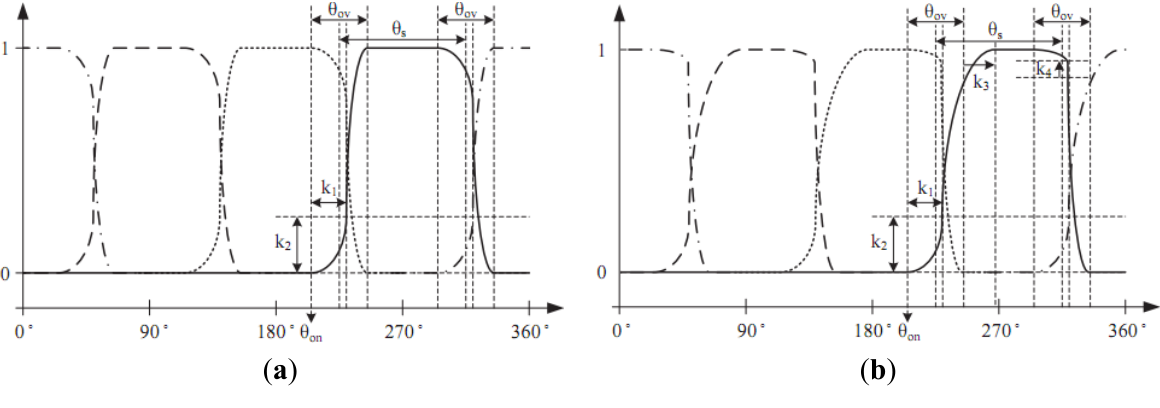
Figure 7. Profiles: ( a ) the asymmetric TSF with a piecewise quadratic curve; ( b ) the proposed non-unity